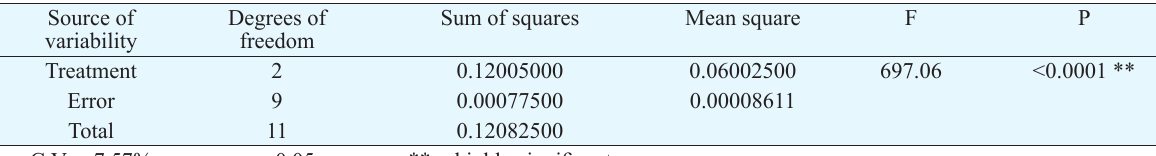
Table 4. Results of the analysis of variance for the percentage mycelial inhibition of Bacillus subtilis and Pseudomonas fluorescens against Corynespora cassiicola .